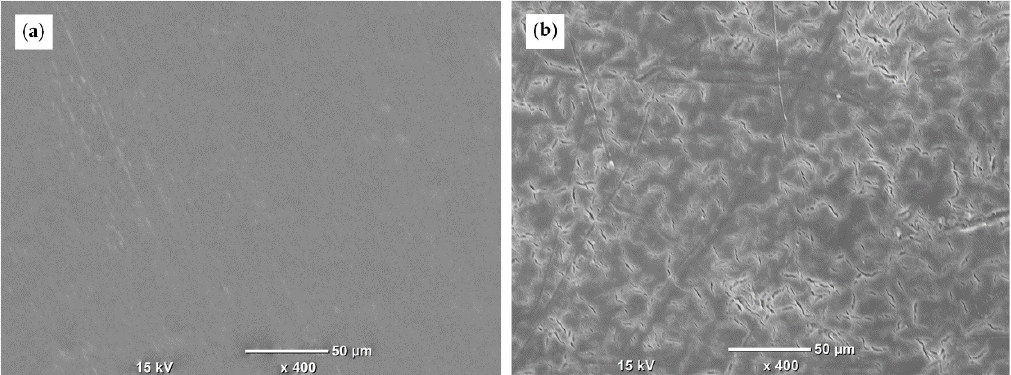
Figure 3. SEM images of the surfaces of polymer film FB4 before ( a ) and after ( b ) 14 day hydrolysis in PBS.